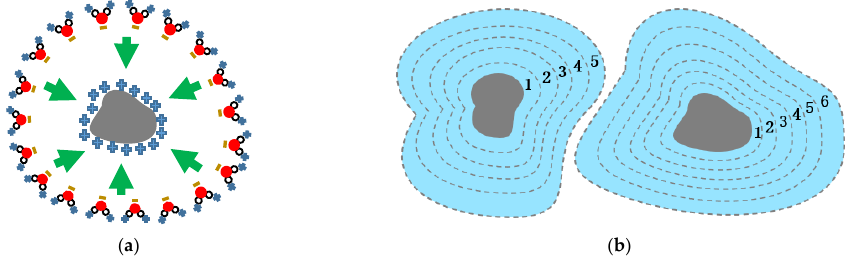
Figure 10. ( a ) Adsorption between water molecules and micro solid particles; ( b ) water film around micro solid particles. The interaction force between micro solid particles: As mentioned above, water film will be adsorbed around the microparticles because of the high specific surface energy. Microparticles can react with each other through the Van Der Waals force of the water film located between them. Consequently, the spacing between microparticles becomes smaller, and the interaction between the particles becomes stronger. In summary, the interaction force between molecules in the slurry prevents the dis- location between molecules, as shown in Figure 11a. When particle 2 tries to dislocate upward, this kind of movement will be limited by the following three forces: firstly, the coulombic force between particle 2 and adjacent particles; secondly, the coulombic force of the water film of particle 2 and adjacent particles and, third, the Van Der Waals force belonging to two adjacent particle water films. These forces prevent the movement of par- ticle 2 and keep particle 2 in a stable suspended state [64], as shown in Figure 11b.